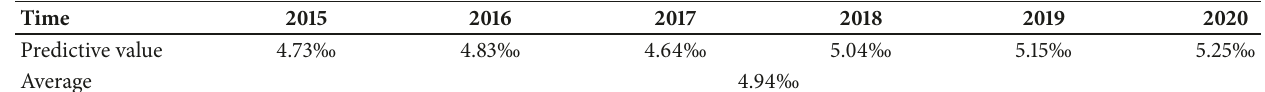
Table 4: Predictive value of death rate and its